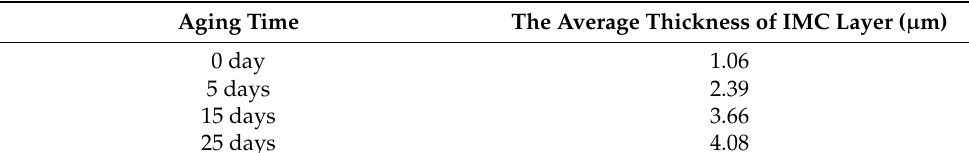
Figure 11. SEM images of the interface between the fully mixed solder joint and the Cu substrate: ( a ) before aging, ( b ) 5 days, ( c ) 15 days, and ( d ) 25 days of aging. Table 3. The thickness of IMC of the fully mixed solder joints before aging and after aging for 5 days, 15 days, and 25 days.